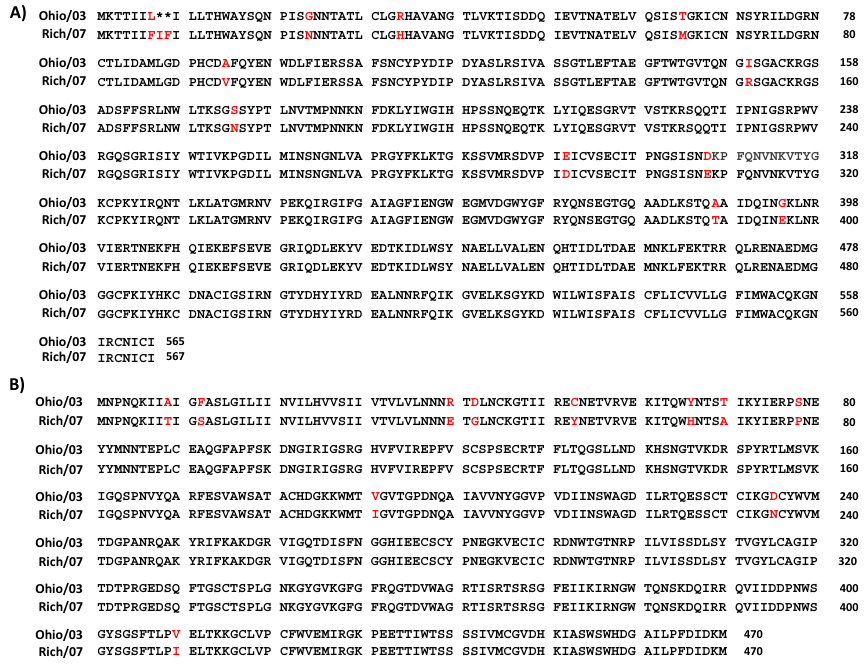
Figure 2. Amino acid sequence alignments of Ohio/03 (top) and Rich/07 (bottom) HA ( A ) and NA ( B ). In red are indicated the amino acid residues that differ between the two viruses present in the EIV bivalent LAIV. Residue numbers are indicated at the right as reference.